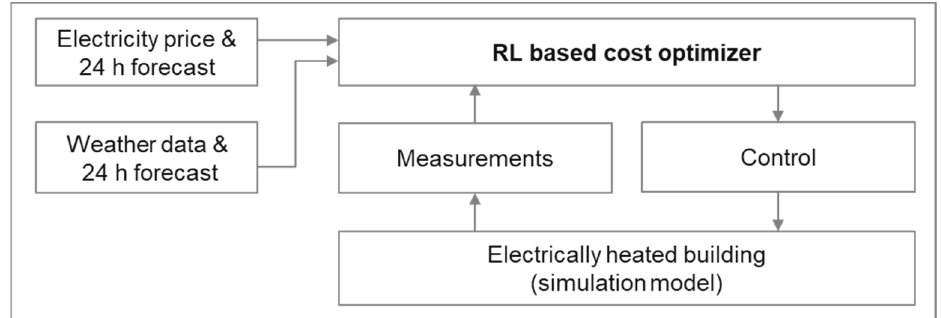
Figure 1. System model for optimizing building electricity cost.